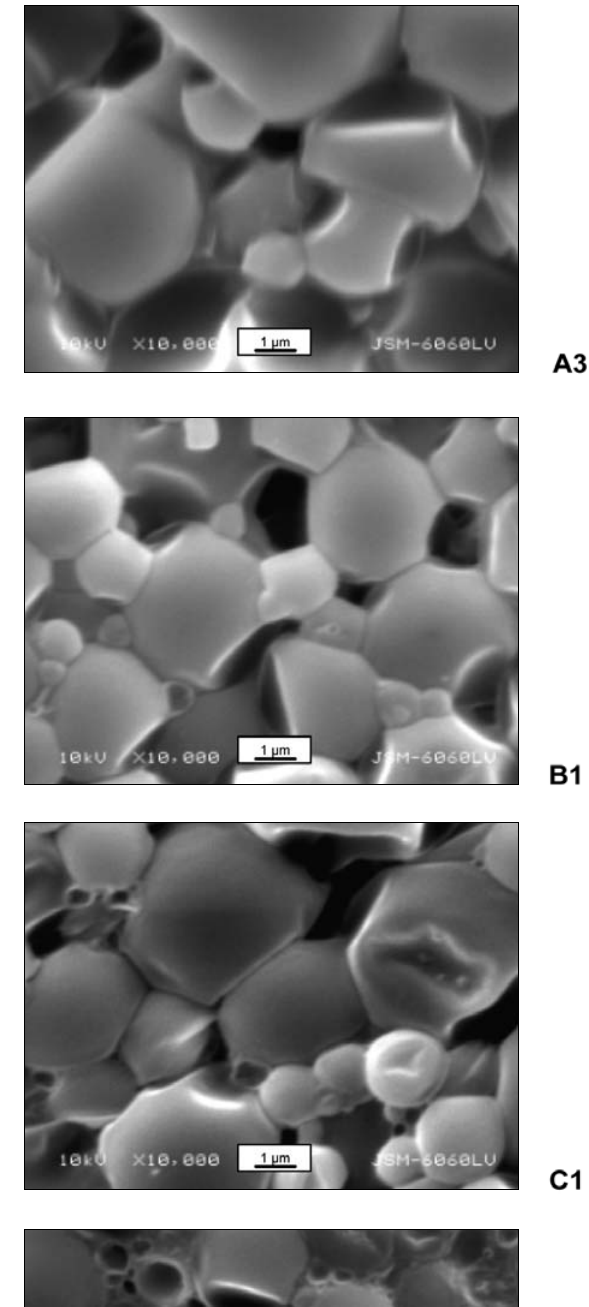
Figure 4. SEM pictures of the poly(urea-urethane) microcapsules prepared with different chain extenders in aqueous phase 2 (A3_EDA, B1_DE- TA, C1_PEG400,